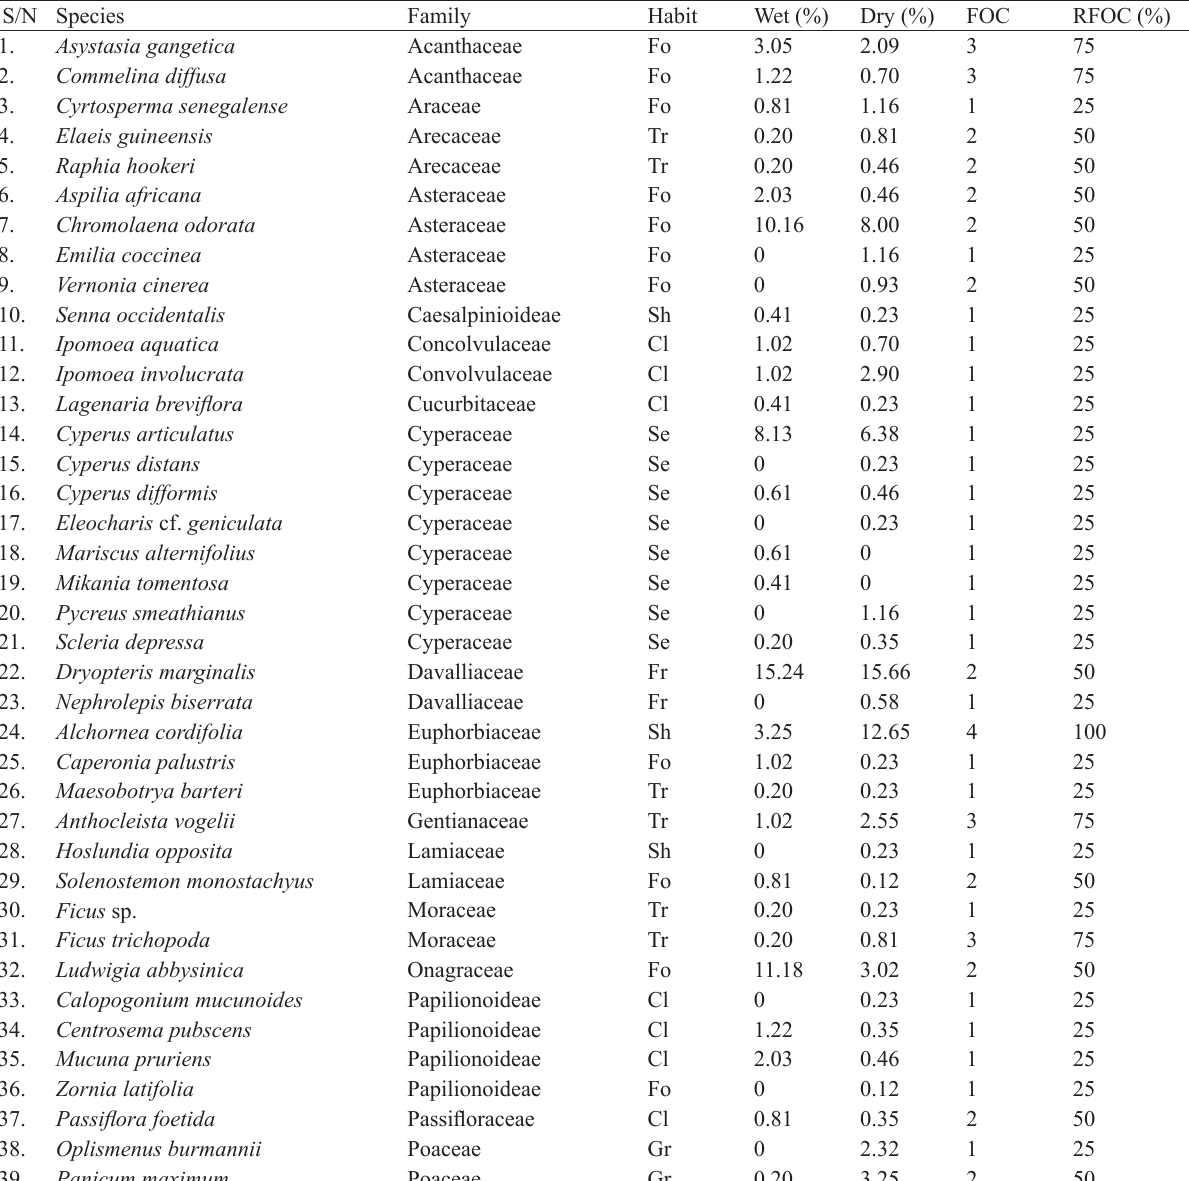
Appendix 1. Percentage seasonal frequency distribution and species occurrence in Badagry, Lagos State.